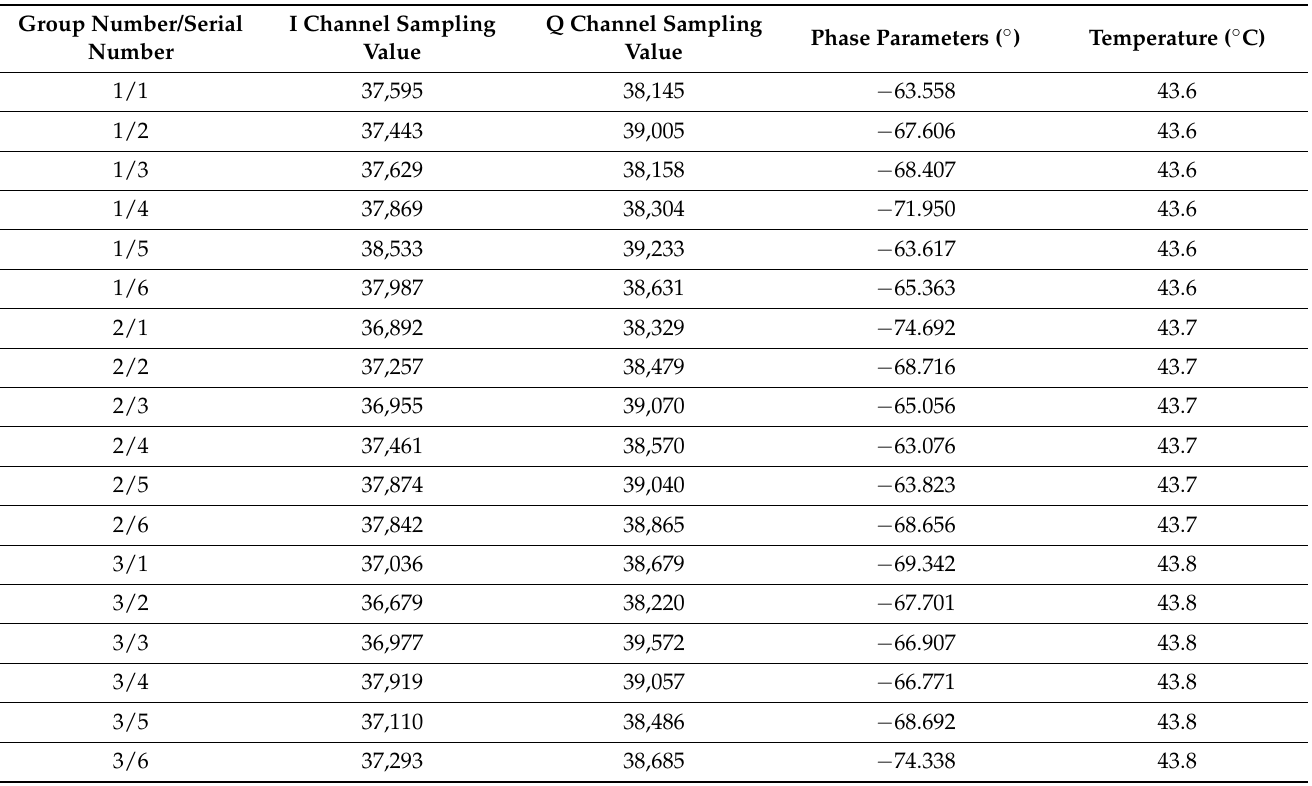
Table 1. Part of the actual experimental measurement results.